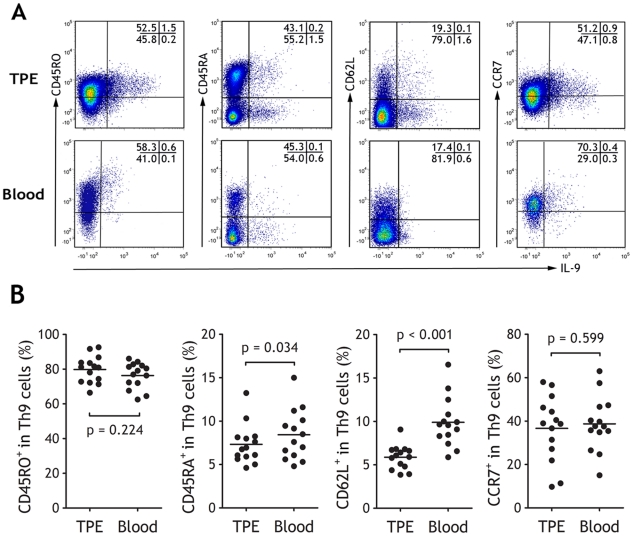
Phenotypic characteristics of Th9 in tuberculous pleural effusion (TPE).(A) The representative dot plots showing expressions of IL-9 and CD45RO, CD45RA, CD62L, or CCR7 on CD4+ T cells. (B) Comparisons of percentages of CD45RO+, CD45RA+, CD62L+, CCR7+ cells in total Th9 cells in TPE and blood from patients with TPE (n = 14). The data are calculated by dividing the numbers in upper right quadrants by the numbers in both upper and lower right quadrants. Horizontal bars indicate means; comparison was made using a Wilcoxon signed-rank test.